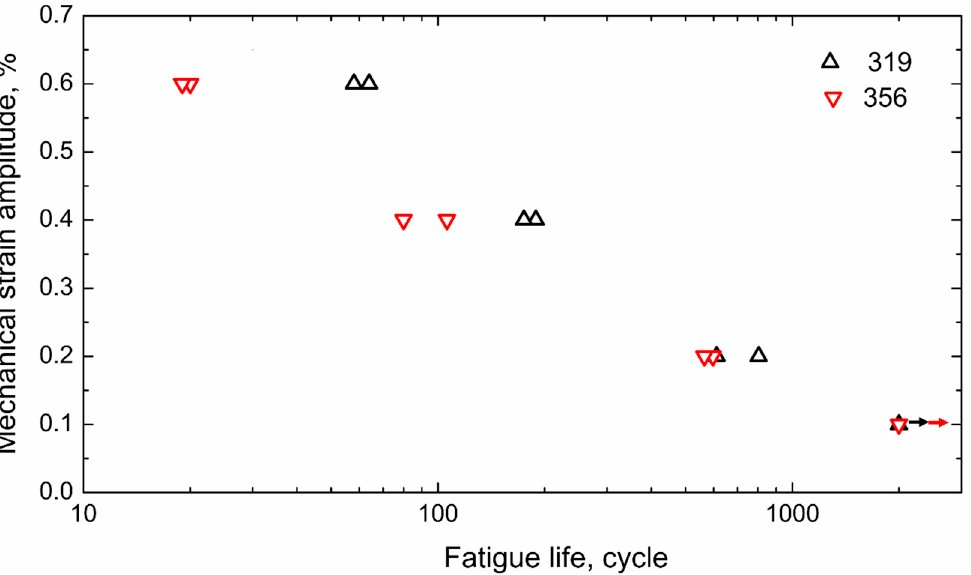
Figure 4. OP-TMF lifetimes of two experimental alloys under various strain amplitudes.